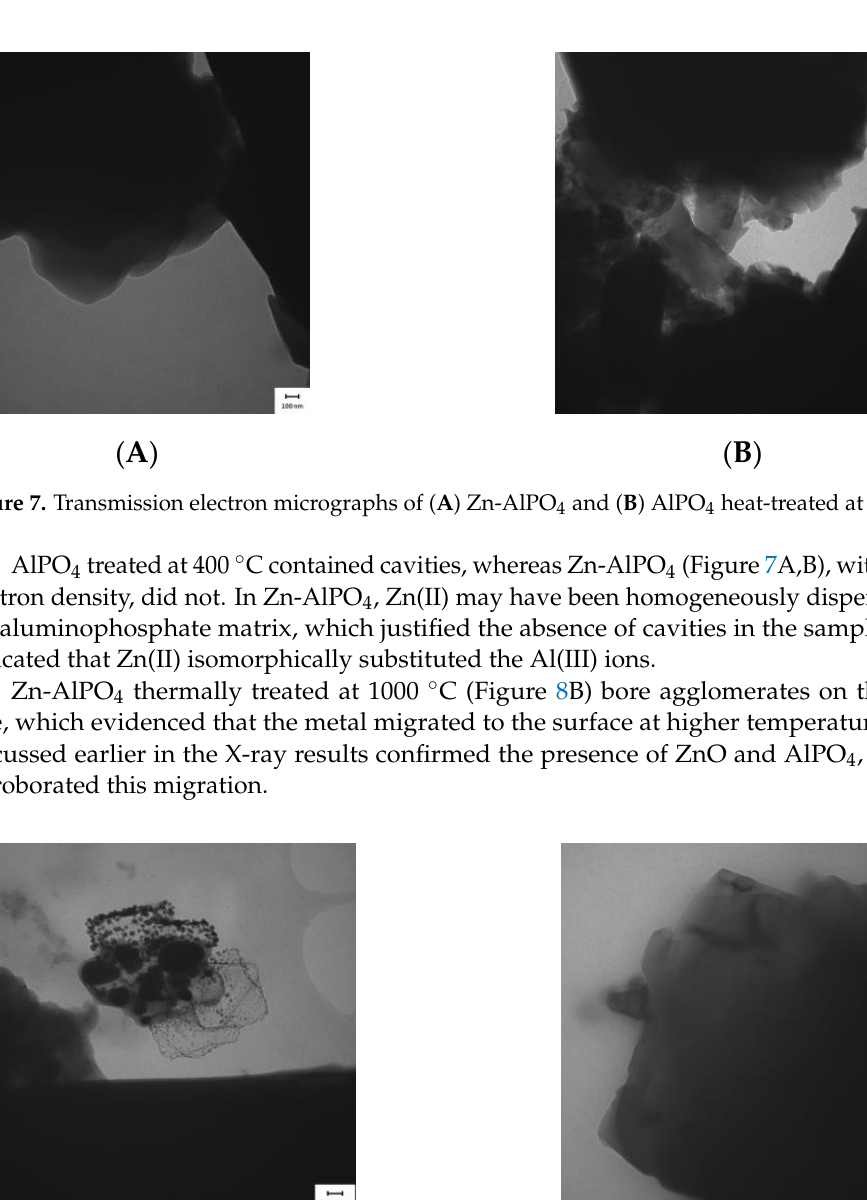
°C. The SEM images depicted in Figures 9 and 10 show that the Zn(II) ions elicited